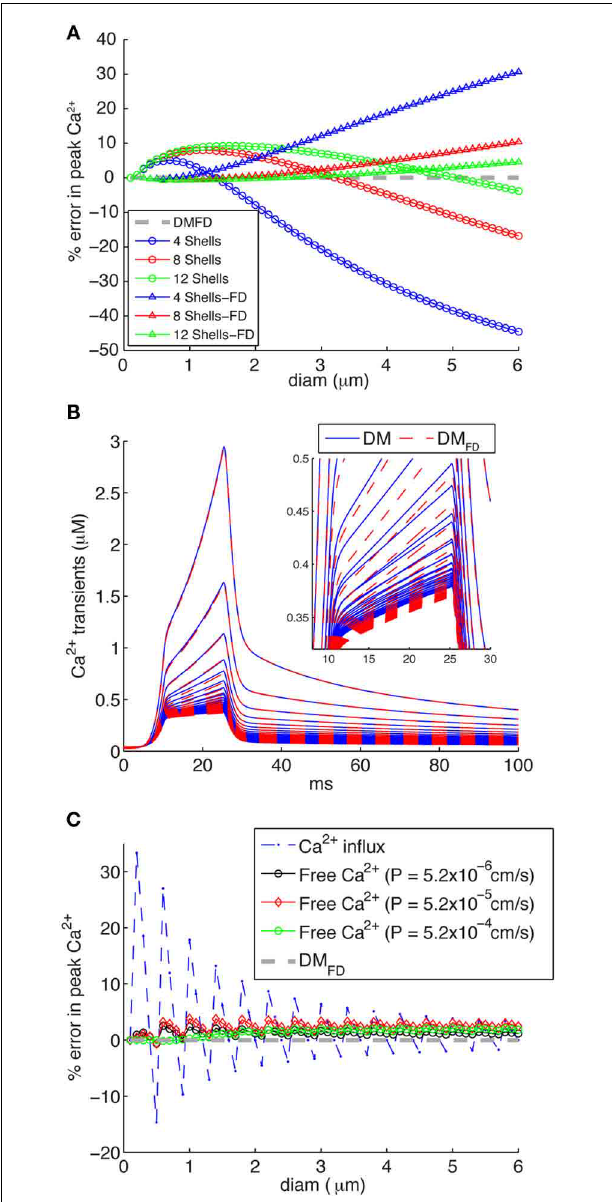
FIGURE 6 | Inaccuracies of different calcium 1D diffusion models result in erroneous calcium levels. (A) Errors introduced by making the number of concentric shells independent of compartment diameter, for 4, 8, or 12 shells respectively. Two mechanisms are implemented: the standard NEURON scheme with variable depths for all shells (circles) and an FD scheme where the submembrane shell has a constant depth d 1 = 0 . 1 μ m and the rest of the shells has variable depth (triangles). The DM FD mechanism is used as reference. Note that for both mechanisms the errors become large for diameters beyond 2 μ m if only four shells are used (as is the case in some NEURON models). (B) Ca 2 + transients generated using a “ramp-like” voltage command in single compartments (see Figure 3C for details) comparing the responses of the DM and DM FD models. Both models show very similar behavior with only small numerical differences. (C) Errors due to discretization of radial shells in DM, which may result in variable d 1 resulting in rapid changes of submembrane shell volume for (Continued)